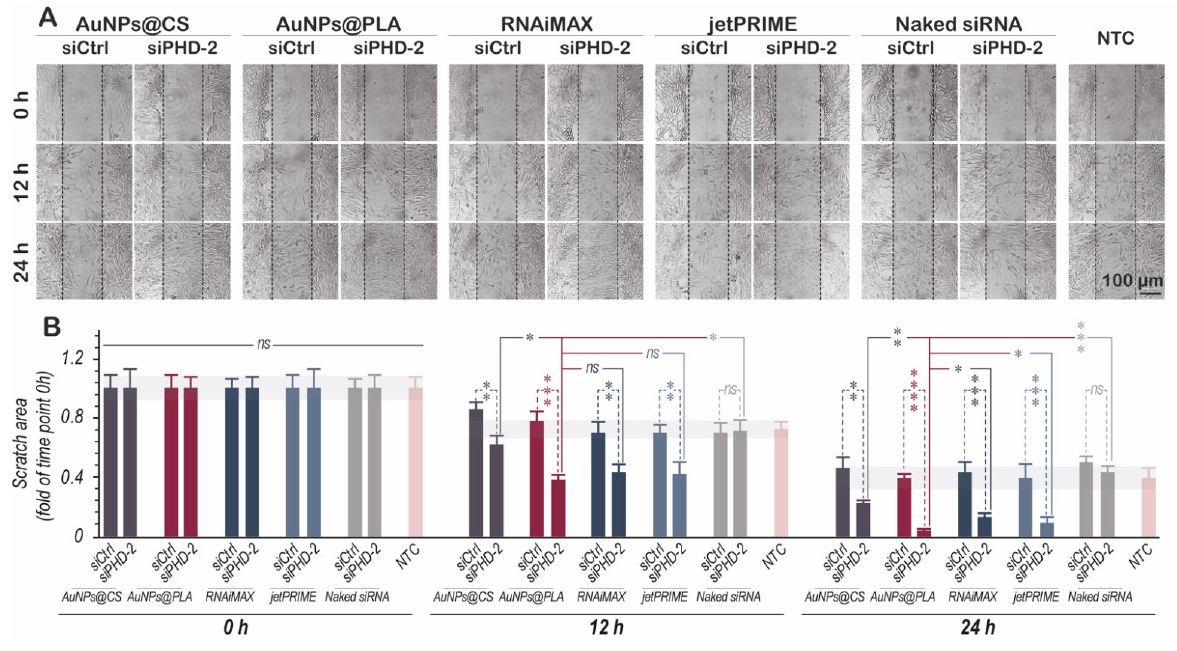
Figure 6. Effects of siPHD-2 transfections on the migration and proliferation of NIH-3T3 cells in a wound scratch assay. ( A ) Representative microscopy images of scratch assays. NIH-3T3 cells were treated with siPHD-2- or siCtrl-loaded nanoformulation for 4 h, followed by 20 h incubation with cell culture medium supplemented with 20 µM DES. After washing and adding fresh cell culture medium, scratches were made of about 100 µm wide. Microscopy images were taken immediately after (0 h) as well as after 12 h and 24 h. The black dashed lines indicate the initial scratch boundaries. The scale bar corresponds to 100 µm. ( B ) Quantitative analysis of the migration area was performed using Image J software at 0 h, 12 h and 24 h. The data are represented as the mean ± standard deviation. (ns = not significant p > 0.05, * p ≤ 0.05, ** p ≤ 0.01, *** p ≤ 0.001, **** p ≤ 0.0001).